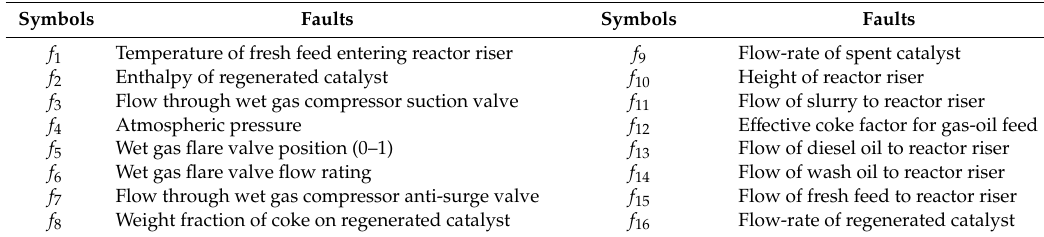
Table 4. Common faults of a fluid catalytic cracking unit (FCCU).